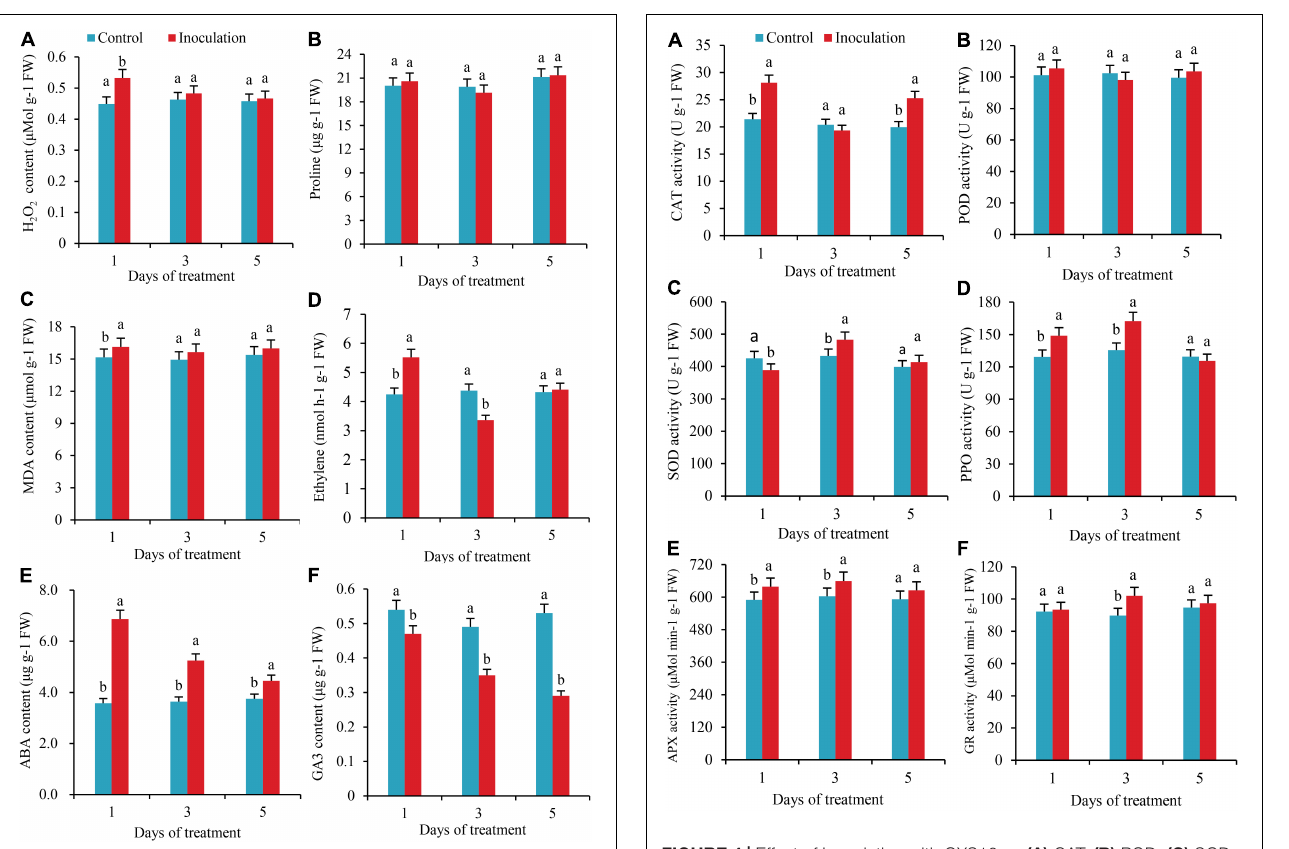
FIGURE 4 | Effect of Inoculation with GXS16 on (A) CAT, (B) POD, (C) SOD, (D) PPO, (E) AXP, and (F) GR activity in sugarcane roots. Values are mean, and vertical bars indicate the standard deviation of three replications. Means followed by the same letter within a column are not significantly different ( p < 0.05) according to Duncan’s multiple range test (DMRT). CAT, catalase; POD, peroxidase; PPO, polyphenol oxidase; SOD, superoxide dismutase; PPO, polyphenol oxidase; AXP, ascorbate peroxidase; GR, glutathione